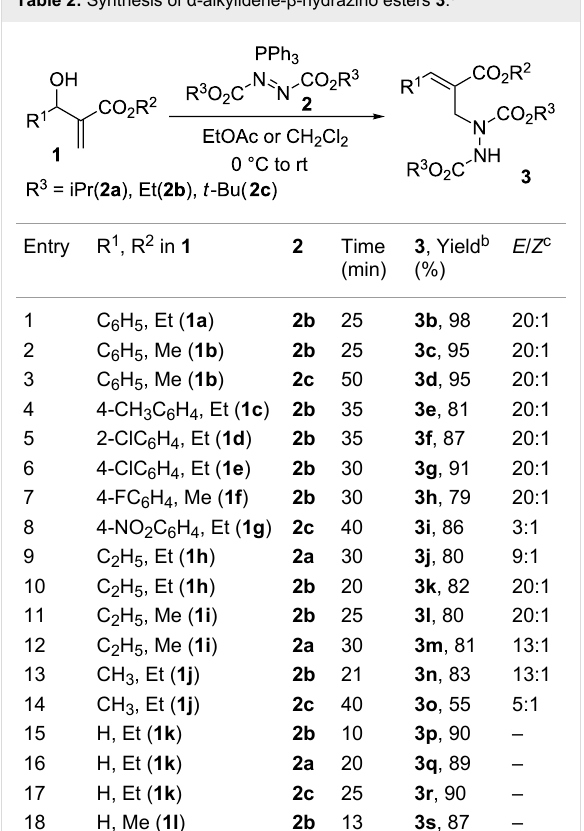
Table 2: Synthesis of α -alkylidene- β -hydrazino esters 3 .